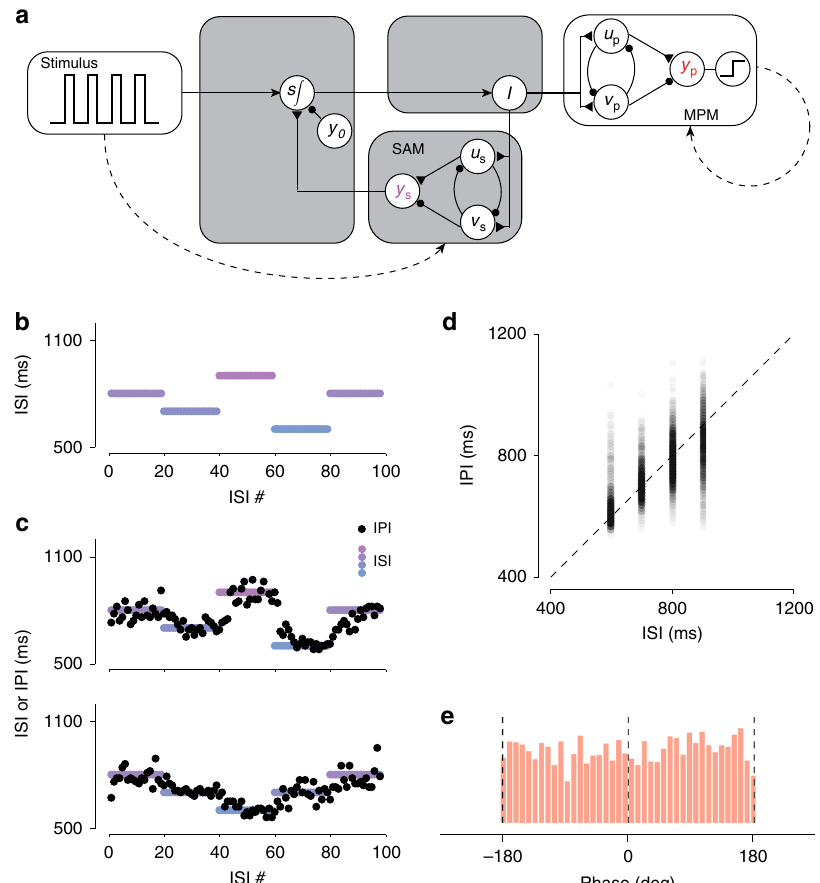
Fig. 4 Online adjustment of inputs allows a combined circuit to match IPI to stimulus ISI. a Wiring diagram of the circuit model that combines the sensory anticipation module (SAM) with the motor planning module (MPM). Conventions as in Fig. 2 and 3. b Example inter-stimulus-interval (ISI) sequence for a trial of the ISI tracking task. Colors indicate different ISIs. We initiated each trial with a block of twenty consecutive 800 ms ISIs. Each subsequent block of 20 ISIs was randomly selected from a discrete uniform distribution between 600 and 900 ms. Each trial consisted of 5 blocks and 100 total ISIs. c Inter-production-intervals (IPIs; black circles) associated with each ISI (colors) for two example trials of the ISI tracking task. d Density of IPIs (grayscale) as a function of the associated ISI. Dashed line indicates perfect tracking. e Distribution of the phase of motor output. A phase of 0 indicates output that is synchronous with the stimulus